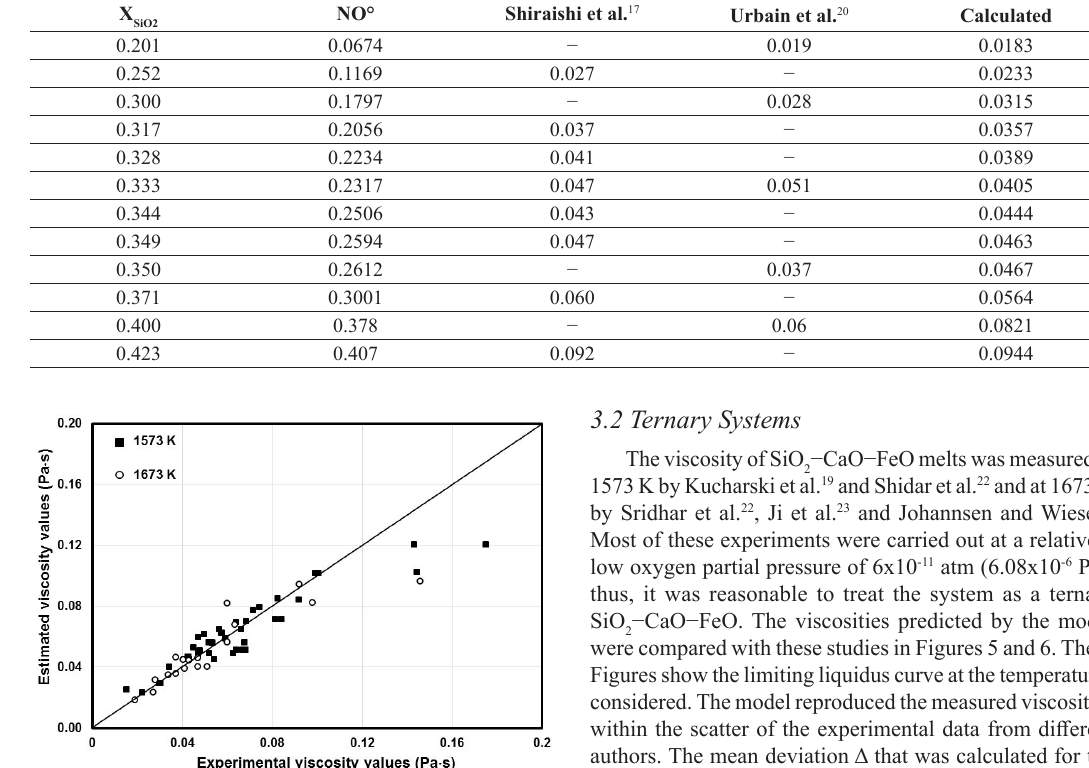
−FeO system at 1673 K, in Pa ⋅ s. 2